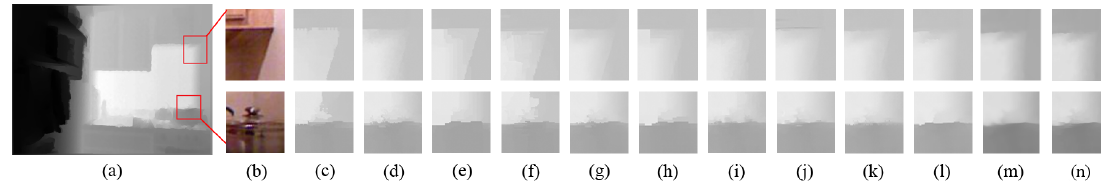
Figure 13. Example depth map SR results of Kitchen2 with two ROI. ( a ) Ground truth depth map, ( b ) color regions, and SR results of ( c ) Diebel et al. [22] (BP% = 6.04) , ( d ) JBU [11] (3.21) , ( e ) Lu et al. [23] (3.01) , ( f ) Kim et al. [24] (3.23) , ( g ) Jung [17] (2.71) , ( h ) Lo et al. [3] (2.96) , ( i ) Park et al. [26] (3.64) , ( j ) Ferstl et al. [27] (2.78) , ( k ) Choi et al. [18] (2.86) , ( l ) Lo et al. [21] (1.73) , ( m ) Our method (0.74) , and ( n ) the associated ground truth.